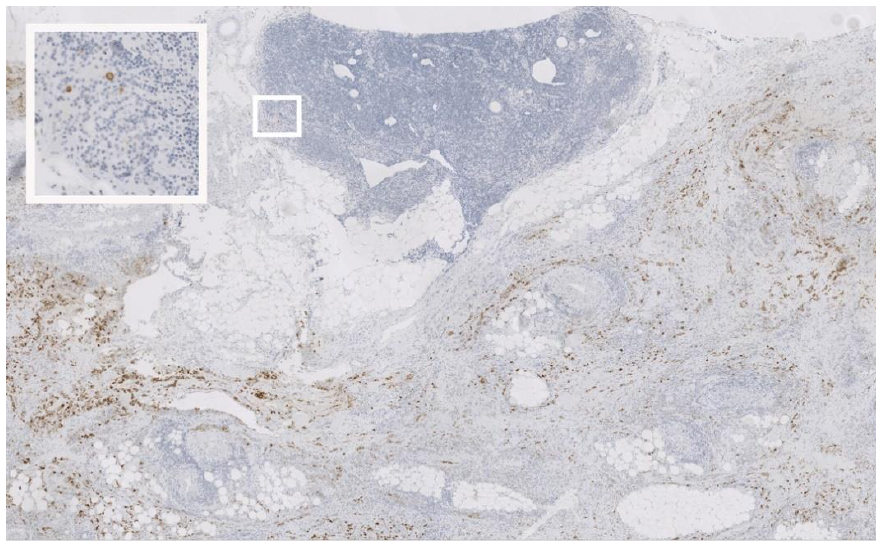
Figure 2. CK19-immunohistochemistry; Original magnification: 5×; A lymph node with surrounding fatty tissue can be appreciated. CK19-positive cells are found almost exclusively outside the lymph node. Only a few isolated tumor cells are identified—(insert: magnification 40×). This lymph node was positive by OSNA.